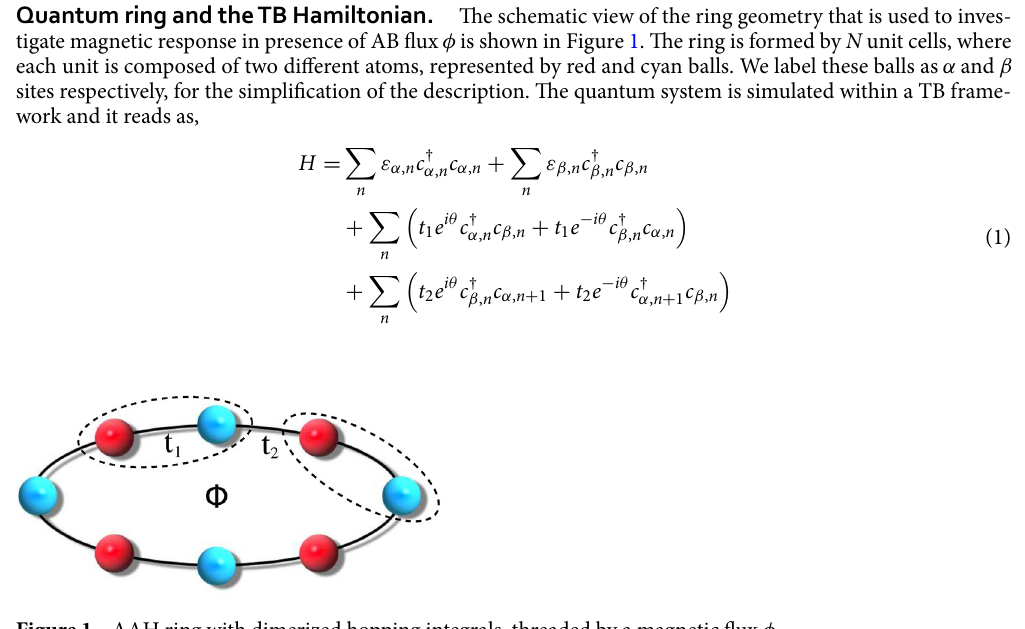
Figure 1. AAH ring with dimerized hopping integrals, threaded by a magnetic flux φ